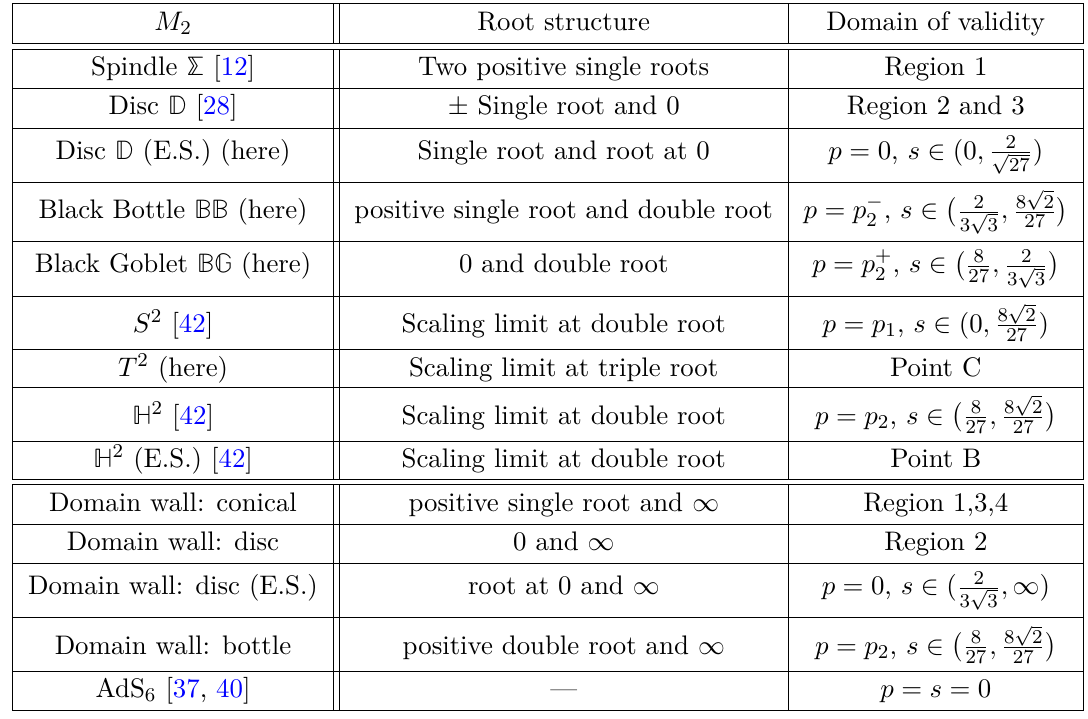
Table 2 . The different choices of global completion and the values of p, s giving rise to such solutions. We have indicated where these solutions were first considered, in some cases it is in this